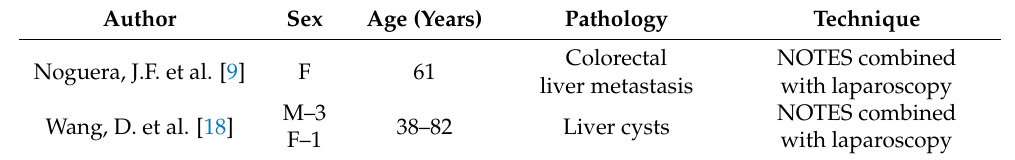
Table 2. General overview of NOTES